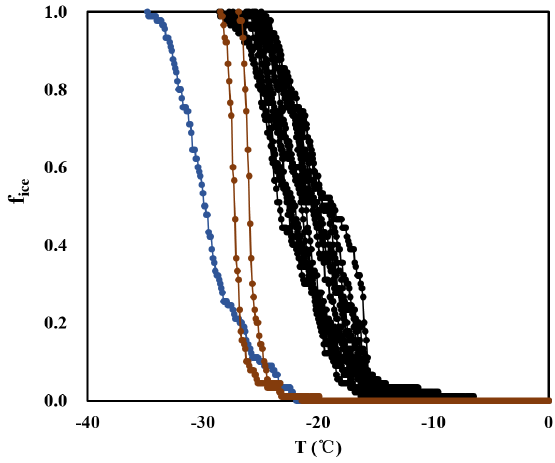
Figure A2. Frozen fractions determined from LINA, together with background signals determined for pure water and for pure water in which a clean filter was put and washed, similar to the procedure for the